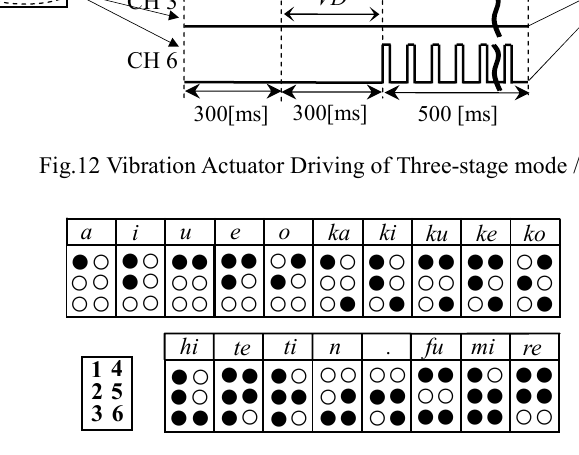
Fig.13 Japanese Table 2 Combination of Vibration Frequency and Time Delay